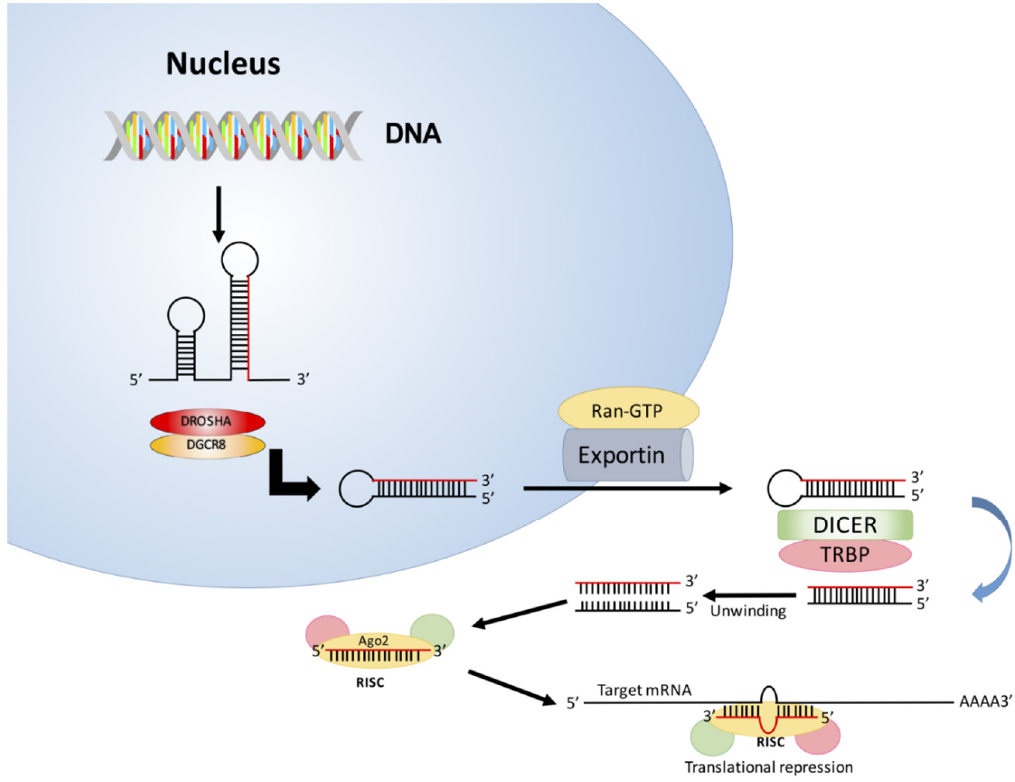
Figure 1. The biogenesis of microRNA.